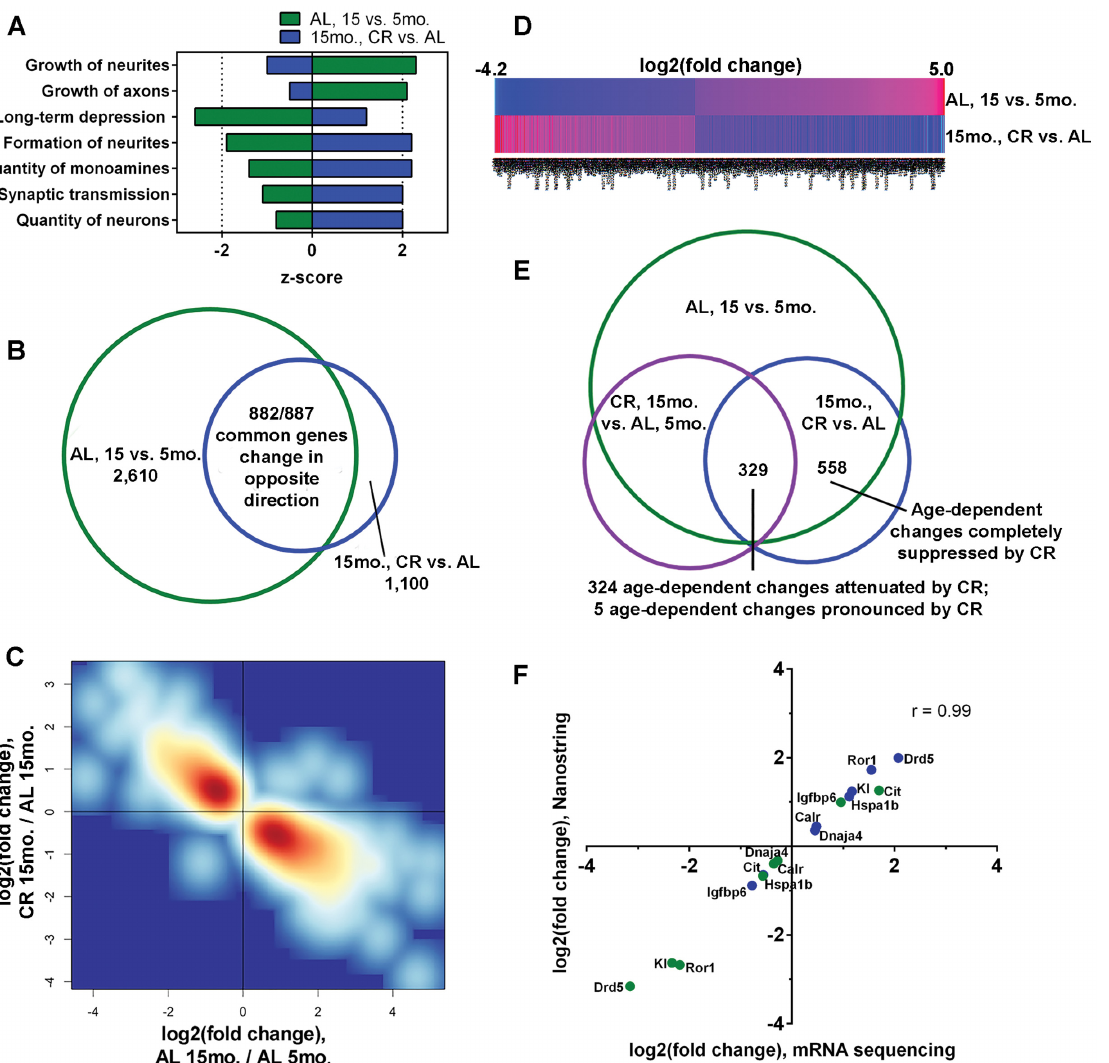
Fig 4. Long-term CR opposes age-dependent cellular functions and reverses age-dependent gene expression in the hippocampal CA1 sector. (A) Comparative IPA was used to predict opposing functions activated (z-score (cid:1) 2) or inactivated (z-score (cid:1) -2) within the AL, 15 vs. 5 month and 15 month, CR vs. AL datasets. (B) 882 of the 887 gene changes common to the normal aging (AL, 15 vs. 5 month) and CR diet in aged CA1 (15 month CR vs. AL) datasets occur in the opposite direction. (C) Smoothed density representation of the normal aging changes (AL 15 month/AL 5 month) versus the CR diet in aged CA1 changes (CR 15 month/AL 15 month) for the 887 genes common to both datasets, illustrating CR reversal of age-dependent changes. (D) Heatmap depiction the 882 age-dependent expression changes suppressed by CR, comparing the mean log 2 fold change values for each gene (p < 0.01, q < 0.05). (E) 558 transcriptional changes identified in the AL, 15 vs. 5 month and 15 month, CR vs. AL datasets were not identified in the CR, 15 month vs. AL, 5 month dataset, indicating no significant differences in expression levels for these genes. 329 differentially expressed genes were common to all 3 profiles, and 5 of these age-dependent changes were made more pronounced by CR. For the remaining 324 genes, CR 15 month expression levels were in between AL 5 month and AL 15 month levels (p < 0.01, q < 0.05). (F) Correlation of log 2 fold change levels of 8 genes assessed by mRNA sequencing (p < 0.01, q < 0.05) and NanoString nCounter (p < 0.05); Pearson correlation value (p < 0.0001) is indicated; AL, 15 vs. 5 month (green) and 15 month, CR vs. AL (blue); dopamine receptor D5 (Drd5), receptor tyrosine kinase-like orphan receptor 1 (Ror1), klotho (Kl), heat shock 70 kDa protein 1B (Hspa1b), calreticulin (Calr), DnaJ (Hsp40) homolog subfamily A member 4 (Dnaja4), insulin-like growth factor binding protein 6 (Igfbp6), citron